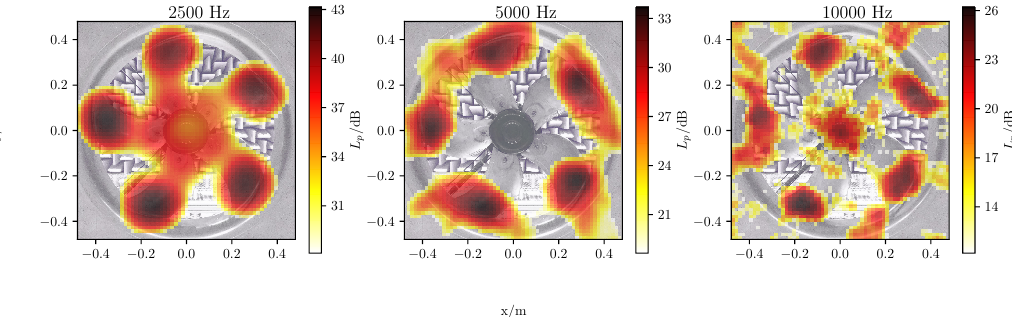
Figure 9. One-third octave band source maps for 2.5, 5 and 10 kHz obtained with the spiral array and barycentric interpolation between the microphones using conventional beamforming.